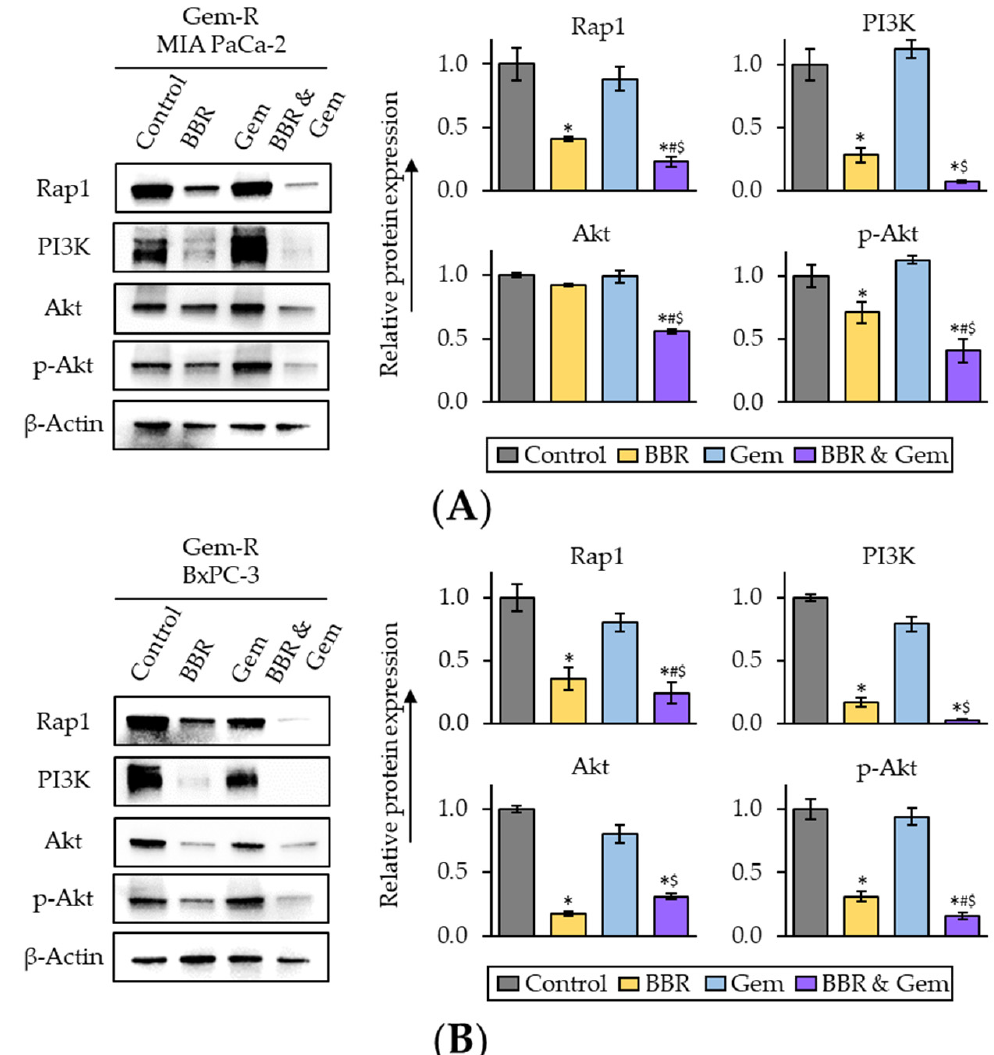
Figure 5. The combination treatment of Berberine and Gemcitabine regulates the activity of Rap1/PI3K-Akt signaling pathway in Gemcitabine-resistant PDAC cells. ( A , B ) Western immunoblotting of Rap1, PI3K, Akt, and phospho-Akt (ser473) (p-Akt) expression in Gem-R MIA PaCa-2 ( A ) and BxPC-3 ( B ) following treatment. The protein of β -Actin was used as an internal control. The average (column) ± SD is indicated (* p < 0.05 vs. control, # p < 0.05 vs. BBR, $ p < 0.05 vs. Gem). Gem-R, Gemcitabine-resistant; PDAC, pancreatic ductal adenocarcinoma; BBR, Berberine; Gem, Gemcita- bine; SD, standard deviation.